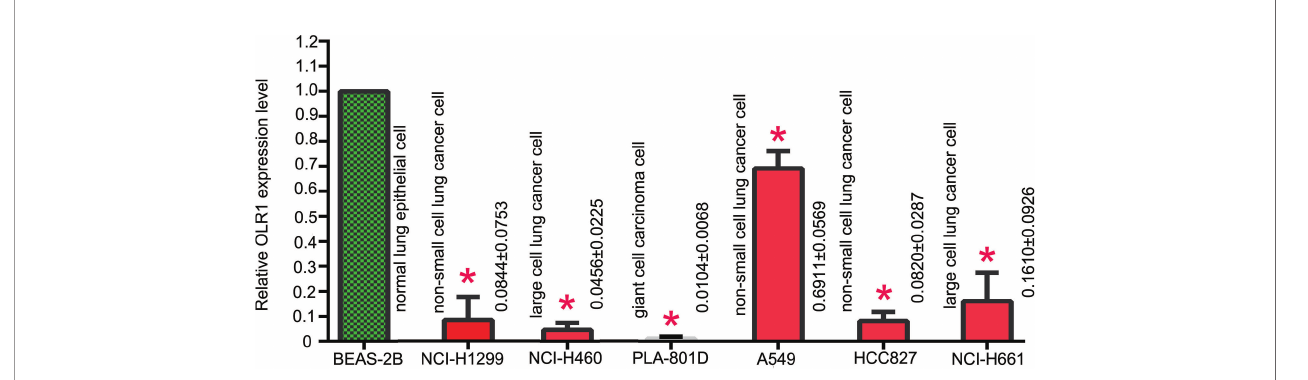
FIGURE 7 | The basic expression level of OLR1 in normal and part NSCLC cell